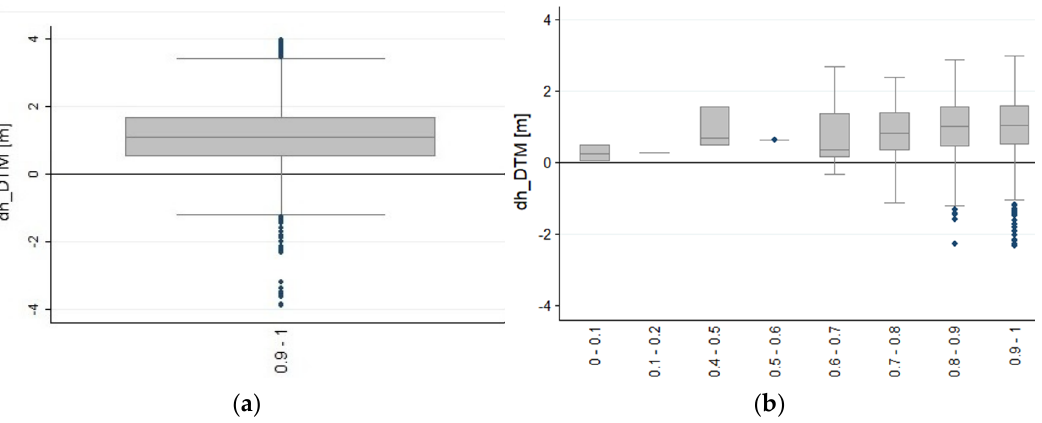
Figure 10. Boxplots showing the distribution of dh-DTM. Data selection with 0.9 sensitivity threshold ( a ). Useful data along all sensitivity ranges ( b ).